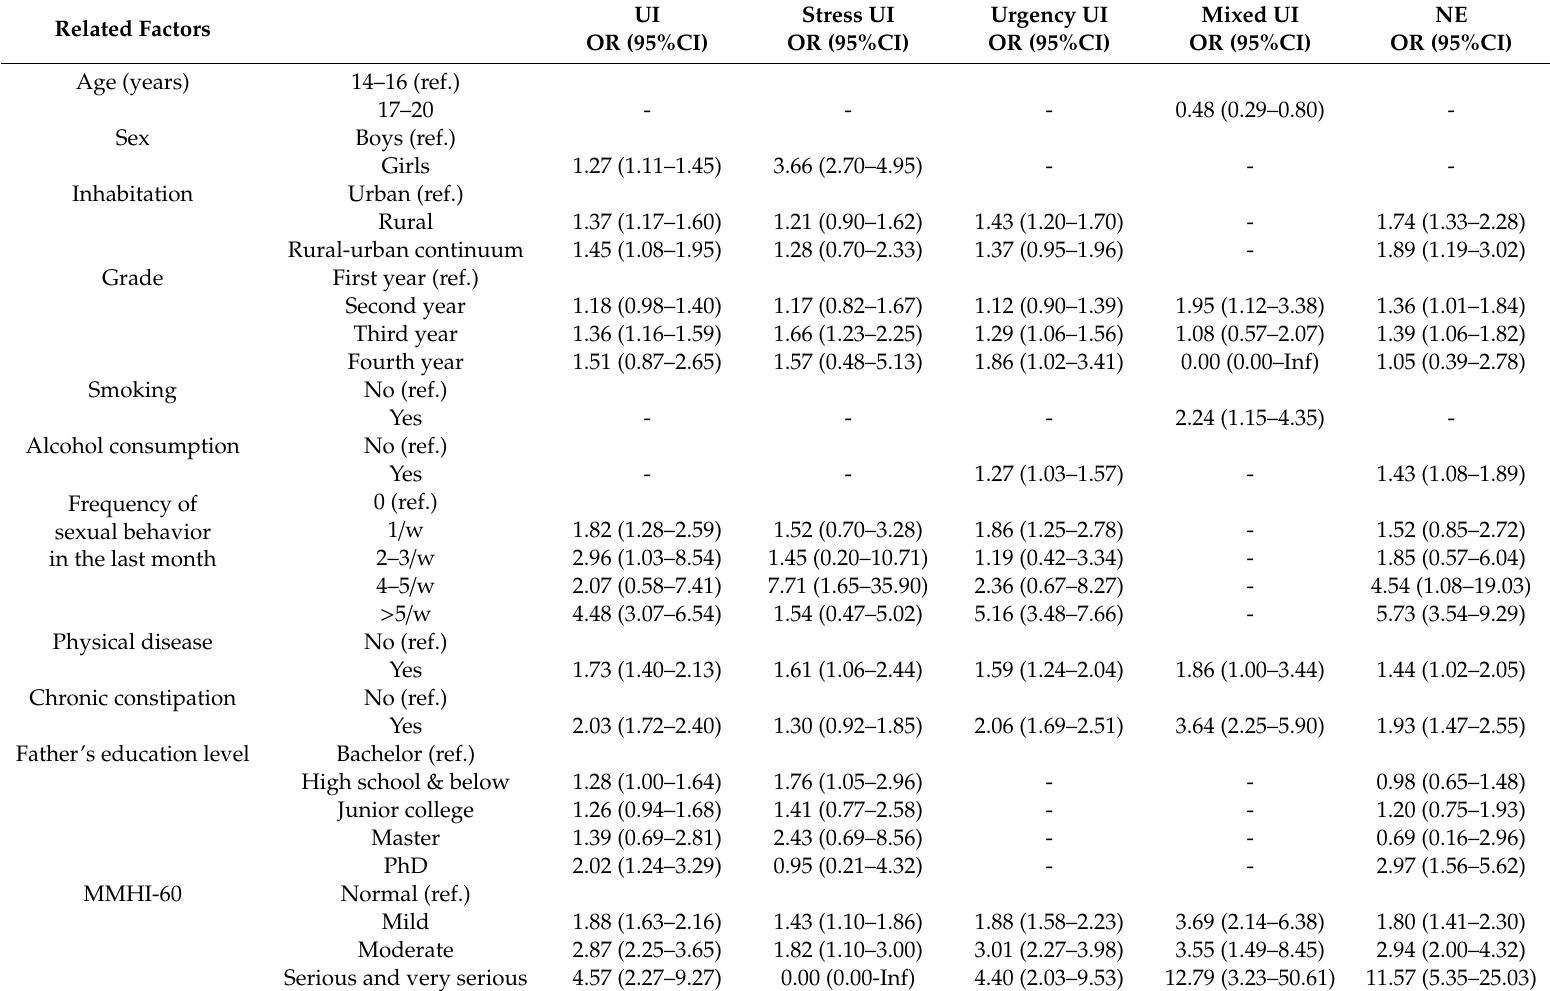
Table 5. Multivariable analysis of factors associated with UI and